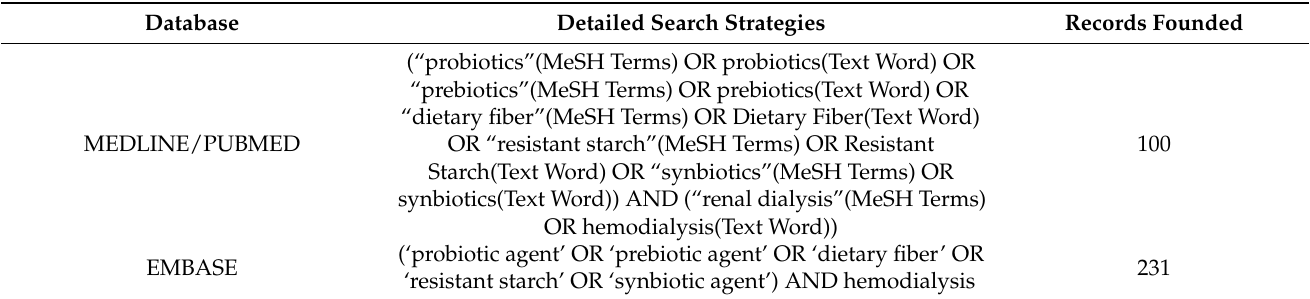
Table A1. Detailed search strategies for each database. MeSH terms, search terms, and combinations of the two were used for each database